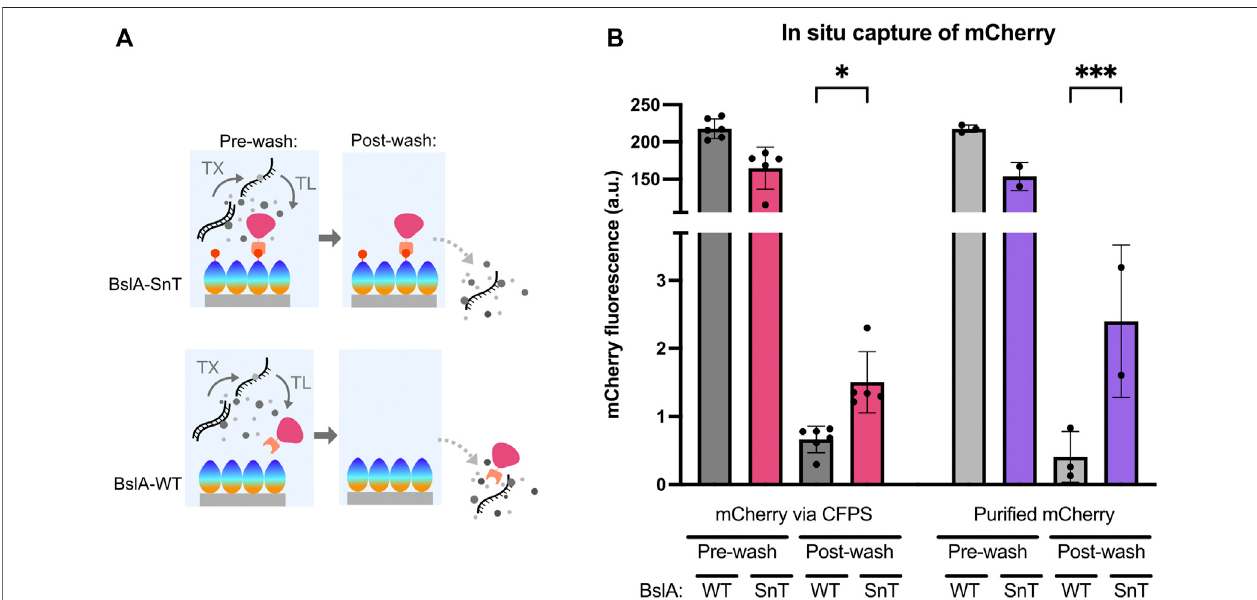
FIGURE4| BslA surfaces speci fi cally capture protein produced in acell-freereaction. (A) Schematic illustration oftheexperiment: ABslA-SnTorBslA-WTsurface isassembledonthesurfaceofahydrophobicallycoated glass slide.mCherry-SnC isproduced byCFPS abovethissurface.Becauseanequal amount ofDNAisadded toeachreaction,weexpectapproximatelyequalamountsof fl uorescentproteinwillbeproducedinbothwells.AfterCFPS,thewellsarewashed.OnlymCherry-SnCthat is bound to the surface will be retained in the well after washing. (B) Experimental data resulting from the experiments illustrated in (A). A similar amount of total fl uorescence is observed in the CFPS reactions performed above the BslA-WT and BslA-SnT surfaces. The wells are then washed, and the retained mCherry fl uorescence is measured. Higher retention of fl uorescence is observed for the CFPS performed above a BslA-SnT surface than above a BslA-WT surface, indicating capture of the mCherry protein synthesised in situ . When puri fi ed mCherry-SnC protein is added exogenously to the CFPS reaction mixture, rather than synthesised in situ ,asimilarresultisobtained:withhigherretentionof fl uorescenceinBslA-SnTwellsthaninBslA-WTwells.Importantly,the fl uorescencevaluesofeachwellbeforeand after washing does not correlate to ef fi ciency of binding, as we expect this concentration of mCherry-SnC to be in excess of the possible binding sites on the surface of each well. Supplementary Information(C) providesestimates ofmaximum binding capacity ofthegivensurface area.Post-wash signalwasanalysed forsigni fi cance by one-way ANOVA using Š ídák ’ s multiple comparisons test. Signi fi cance is denoted by asterisk on the graph between fl uorescence for WT and SnT surfaces post- wash, where * denotes p ≤ 0.05 and *** denotes p ≤ 0.001. Error bars show standard